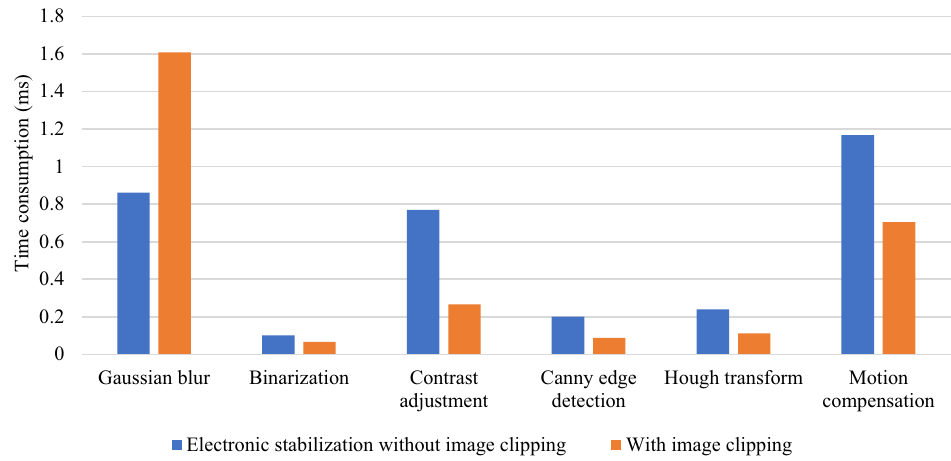
Figure 14. Processing time of each step of electronic stabilization.